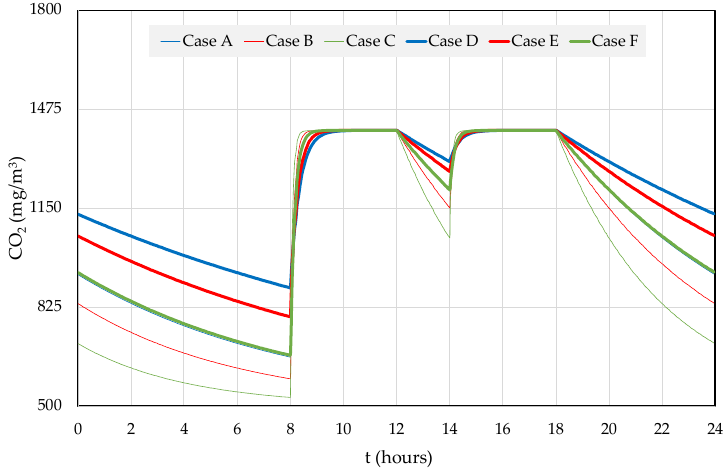
Figure 21. Evolution of CO 2 concentration for the six cases studied.